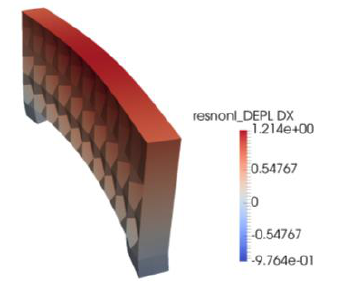
Fig. 10. Deformation of the 'flexible' flap at the time of peak displacement. The deformed shape is amplified by a factor of 4 for visualisation purposes